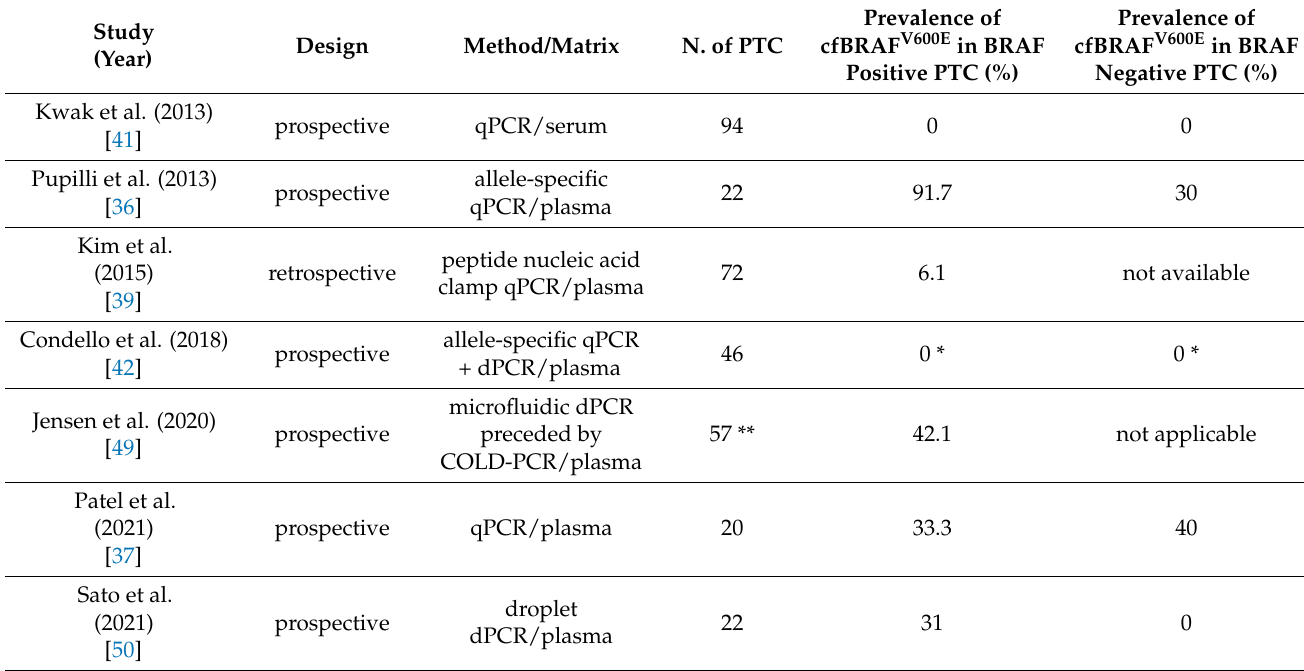
Table 1. Design, methods, size, and findings of studies assessing the prevalence of cfBRAF V600E in PTC patients. Only tumors with available BRAFV 600E mutational status were included. The somatic detection of BRAF V600E was accomplished on primary tumors for all included cases. Prevalence data of cfBRAF V600E were referred to the cfDNA evaluation as performed before thyroid